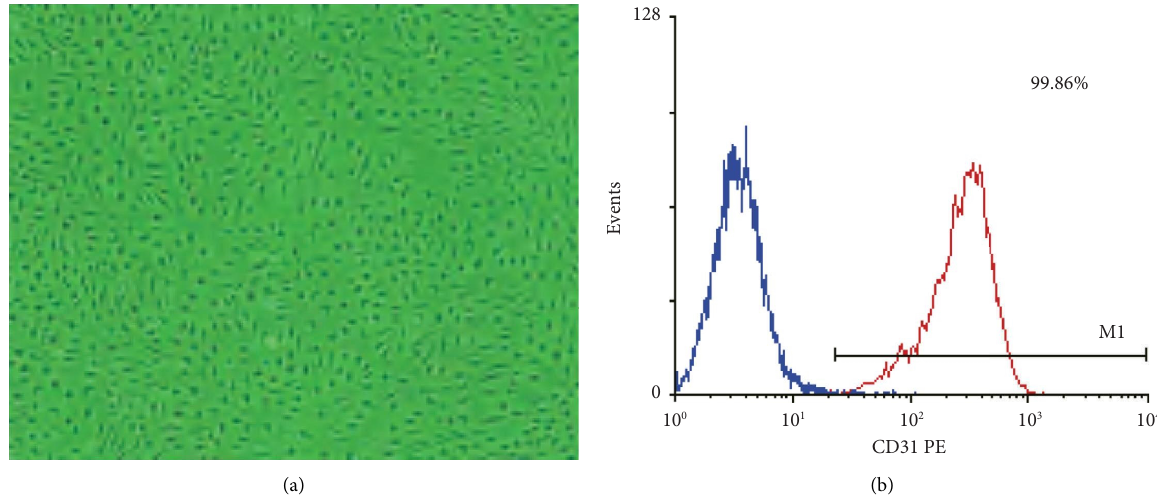
Figure 1: Identifcation of HUVECs. (a) Optical microscopy images of early HUVECs (40 × ). (b) Detection of CD31 on HUVECs surface by fow cytometry.